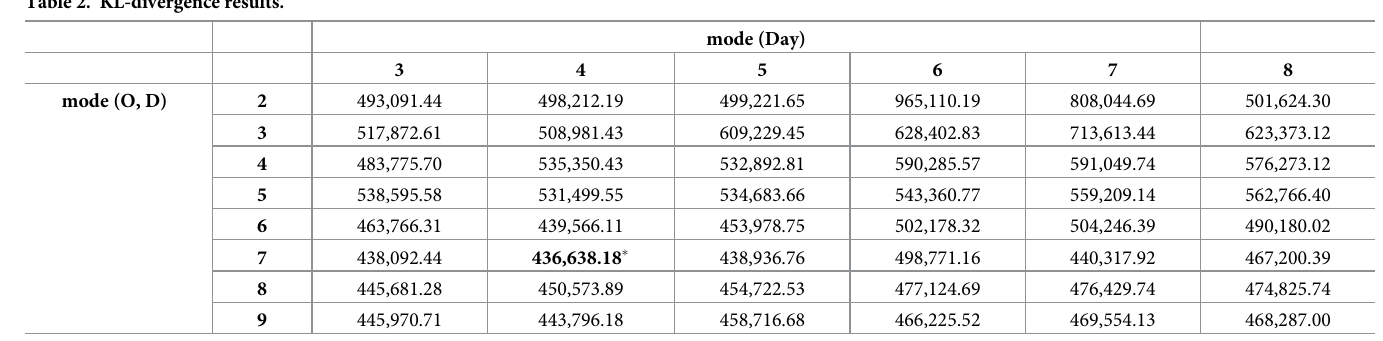
Table 2. KL-divergence results.